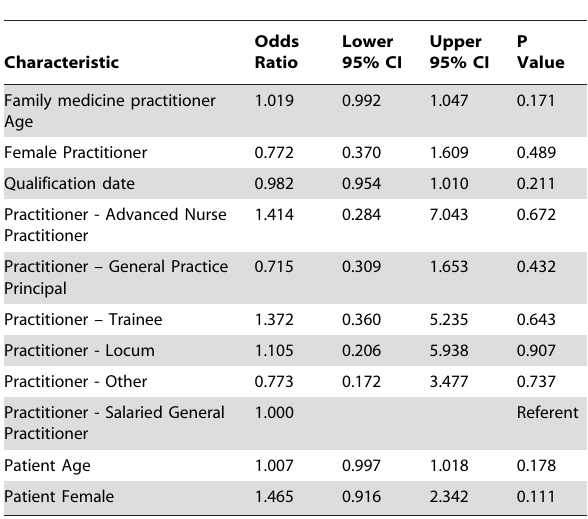
Table 6. Practitioner and patient characteristics and odds of practitioner having inadequate skills in language of consultation – Univariate Analyses.